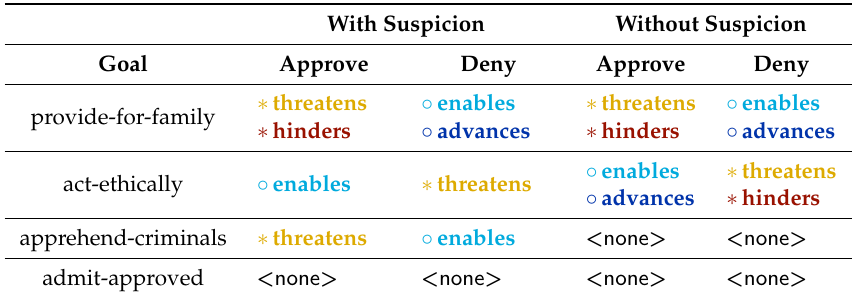
Table 5. Option analysis for the example choice shown in Figure 2. The default analysis is shown on the left (“With Suspicion”), and a revised analysis assuming that the player trusts the applicant (“Without Suspicion”) is shown on the right. See Section 1 for how the labels were applied. With Suspicion Without Suspicion Goal Approve Deny Approve